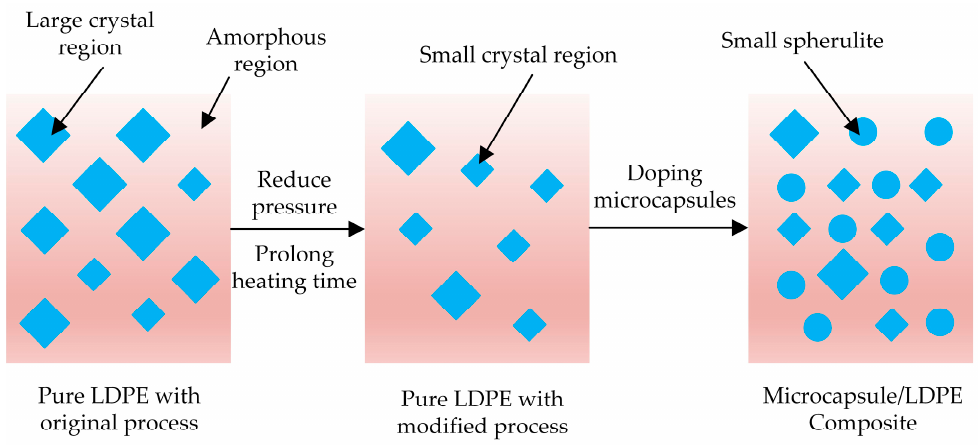
Figure 6. The changes in crystallinity in the polyethylene material.